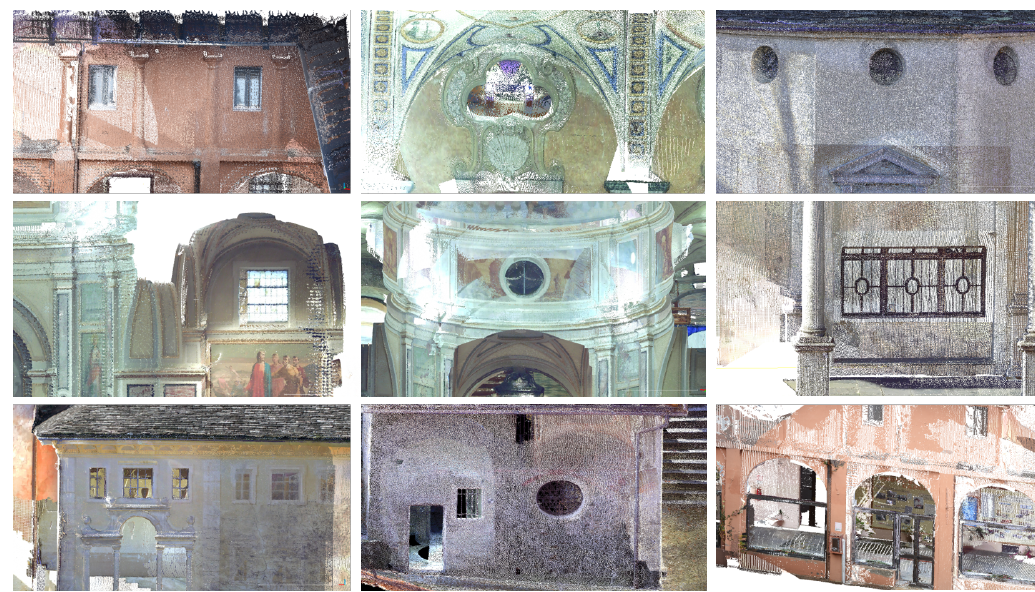
Figure 9. Different typologies of windows and doors. For the latter, their opening has sometimes affected the points